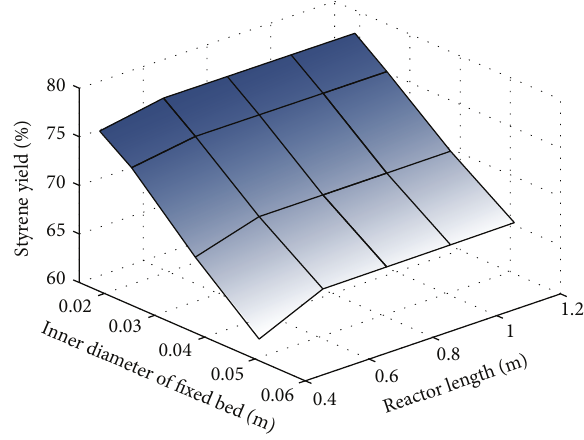
Figure 2: Analyses of reactor geometry.